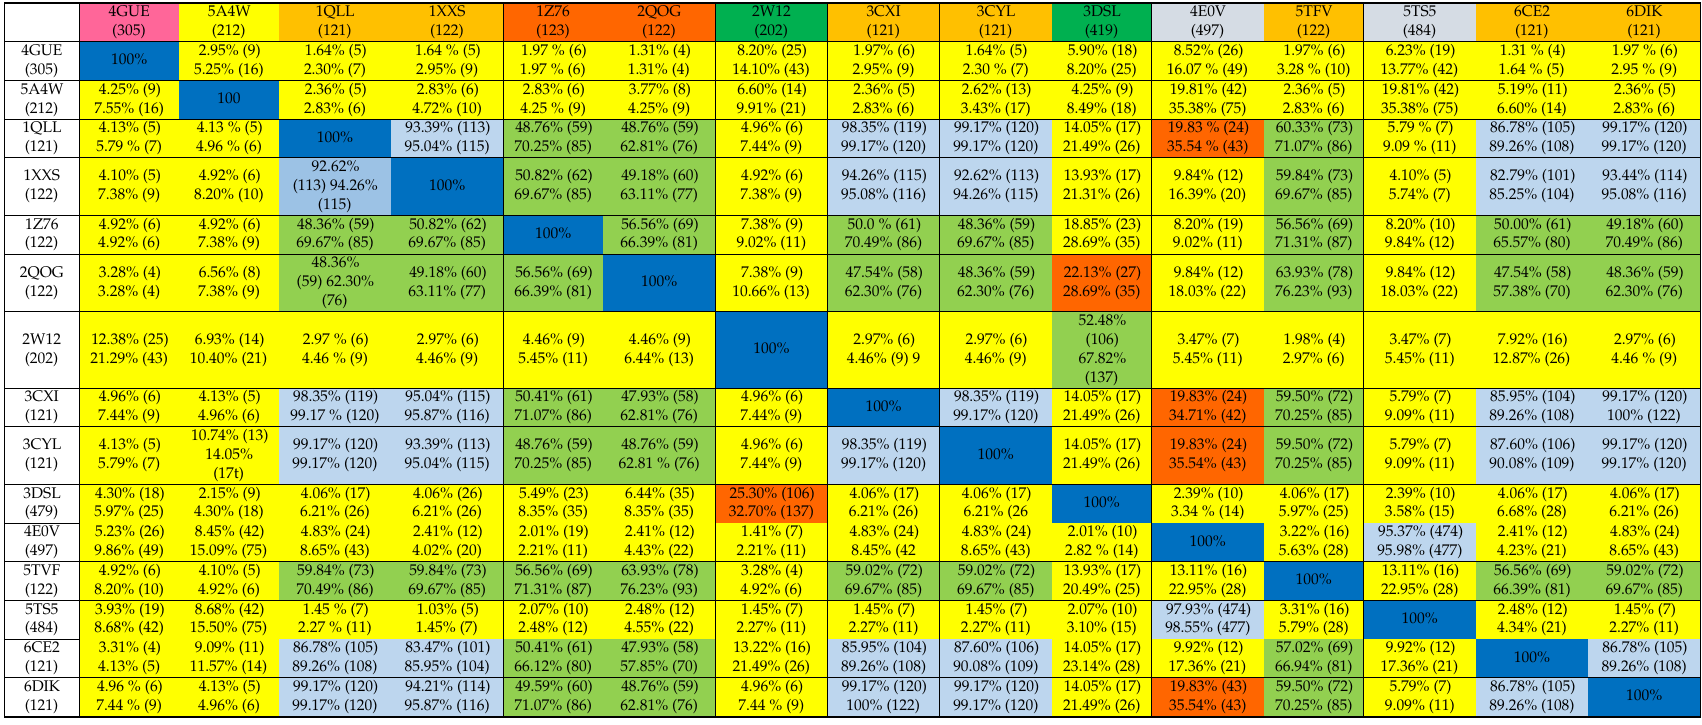
Table A1. Similarity matrix for the target proteins. In each cell the upper number represents the percentage of identity and the lower the percentage of similarity for the protein in that row. The number in parenthesis represent the corresponding amino-acid number after Smith-Waterman comparison of the sequences. The cells are colored according to the percentage of similarity: < 25% yellow, 25–50% orange, 50-75% green and > 75% light blue. Diagonal cells with 100% identity are colored in dark blue. The protein IDs in the upper row have been colored by groups according to their similarity to the rest of the